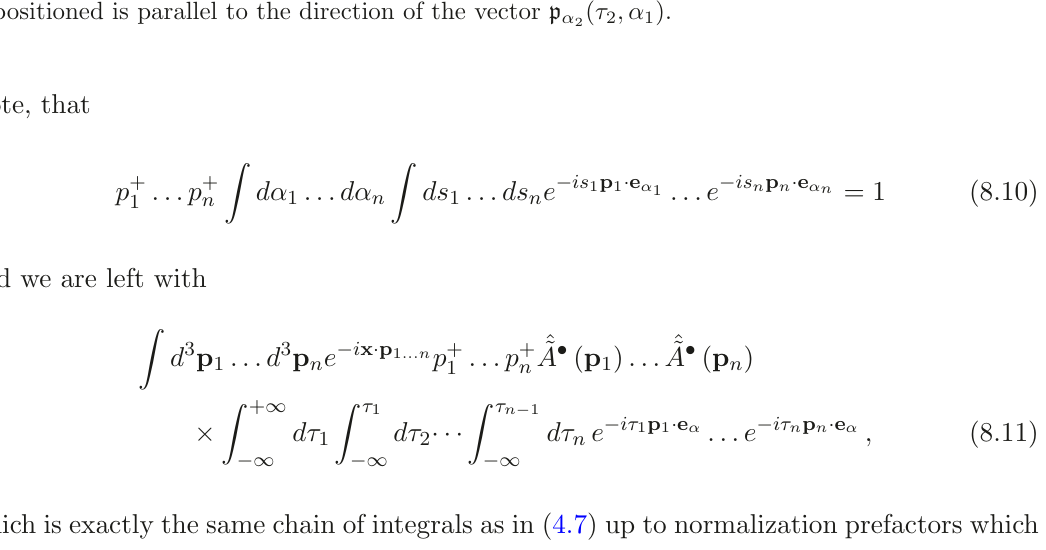
( τ i , α ) lie on the line given by e α . i ( τ i , α ) are scattered on the plane along a i p α ( τ 3 , α 2 ) 2 on which the 3 ( τ 2 , α 1 2